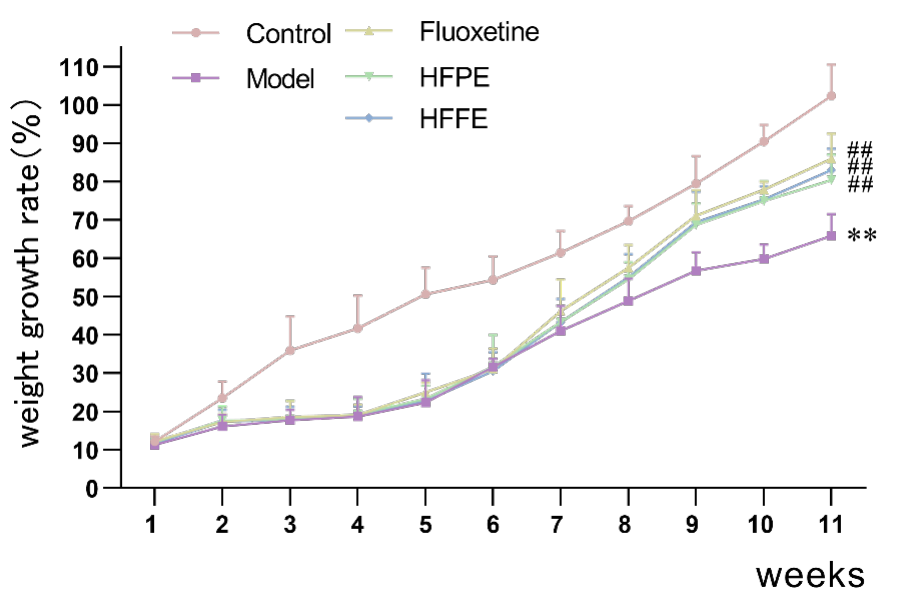
Figure 4. Trends in weight growth rate in each group before and after CUMS treated. The values were represented as mean ± SD ( n = 10). ** p < 0.01 compared with the control group, ## p < 0.01 compared with the model group.